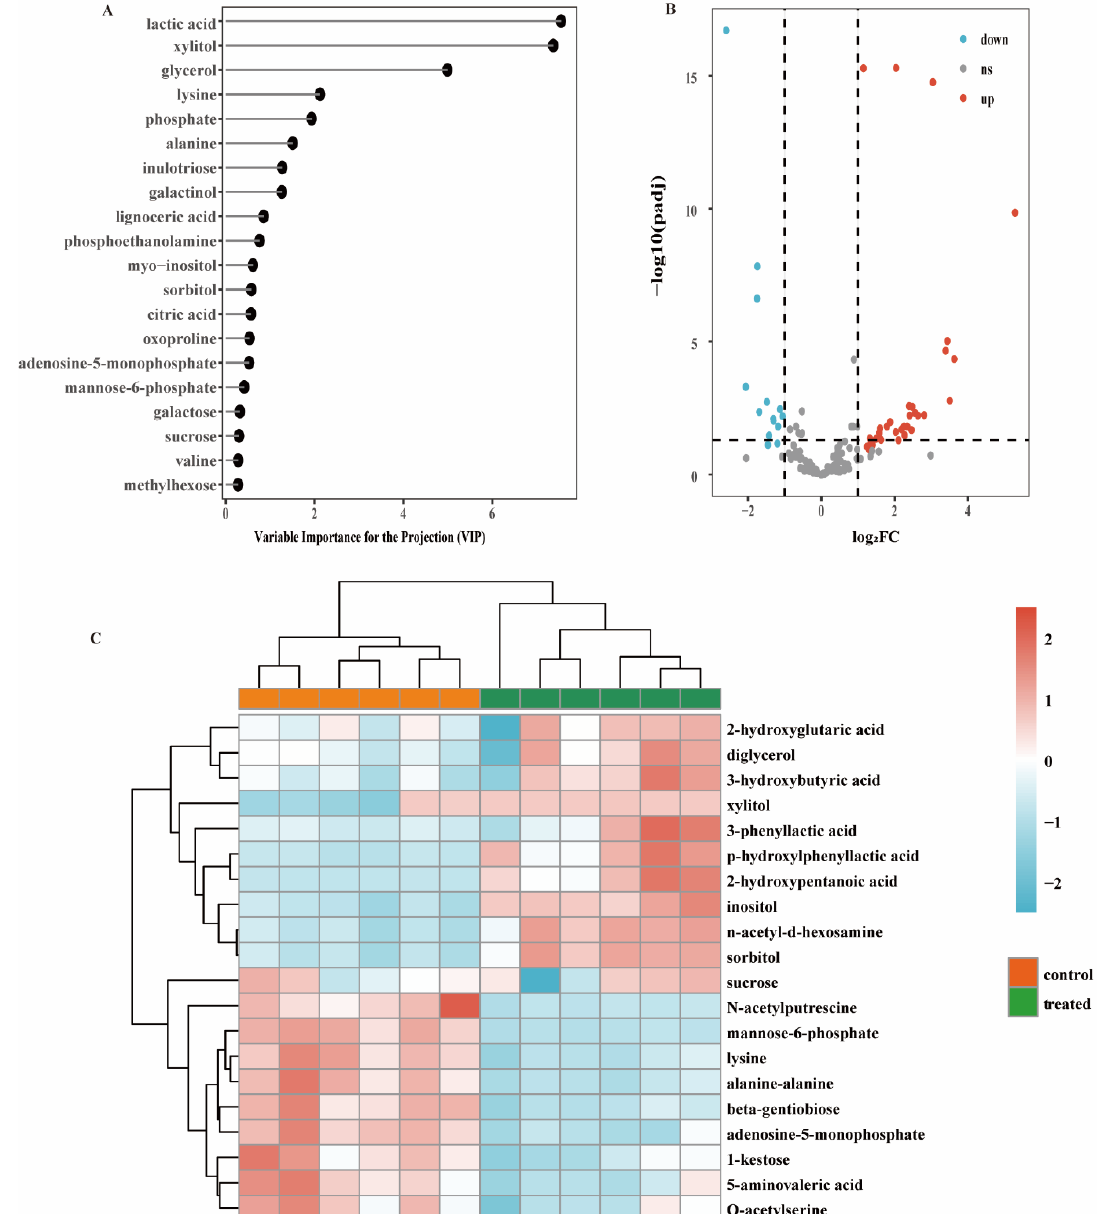
Figure 2. Significantly changed metabolites between groups. ( A ) Variable importance for the projection (VIP) score calculated by PLS-DA. ( B ) Volcano plot of the metabolites from the treated and control biofilms. The blue dots indicate the downregulated metabolites, the red dots indicate the upregulated metabolites, and the grey dots indicate the non-differentially expressed metabolites. ( C ) Heatmap of top 20 significantly changed metabolites. Cluster 1 and cluster 2 represent the two clusters of control and treated group, respectively. The six columns for each cluster represent independent metabolomics replicates.